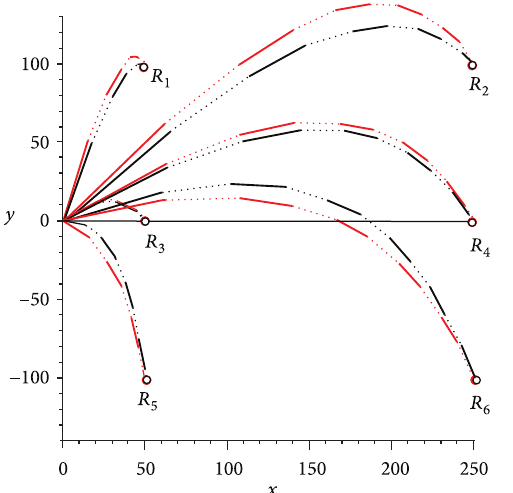
Figure 15: Planning trajectories through six different 𝑅 s while minimizing the initial velocity using the exact method (in black) and the approximate ℎ = 1/4 method (in red) in a medium-fiction scenario.